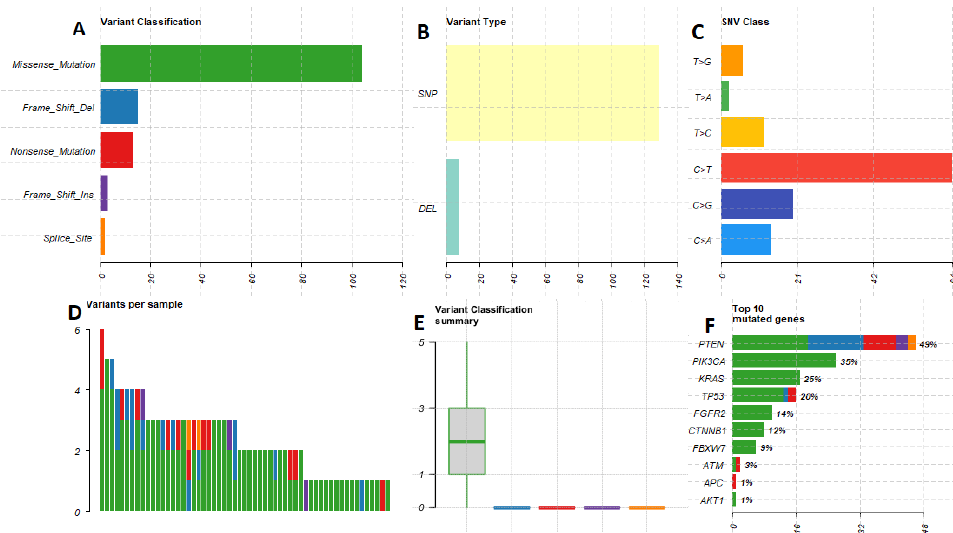
Figure 1. A graphical presentation of molecular findings. ( A ) comparison the mutation types with an evident dominance of missense mutation. ( B ) We noted the single nucleotide polymorphism as a main molecular aberration. ( C ) The cytosine-thymidine shift was observed to be the most frequent. ( D ) The graph presents several mutations in studied cases with emphasis on mutation variants. ( E ) Number of discovered mutations per case with a key role of missense type. ( F ) The variants according to gene. The PTEN gene presents a wide mutation landscape.